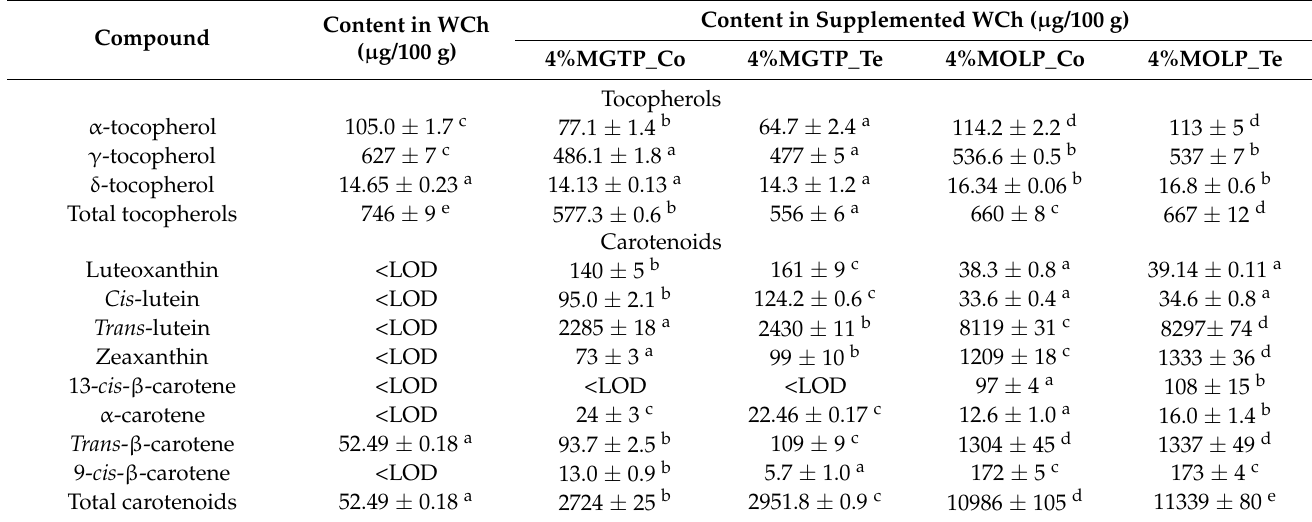
Table 4. Contents of tocopherols and carotenoids in white chocolate without and with 4% matcha green tea powder and moringa leaf powder added during conching and